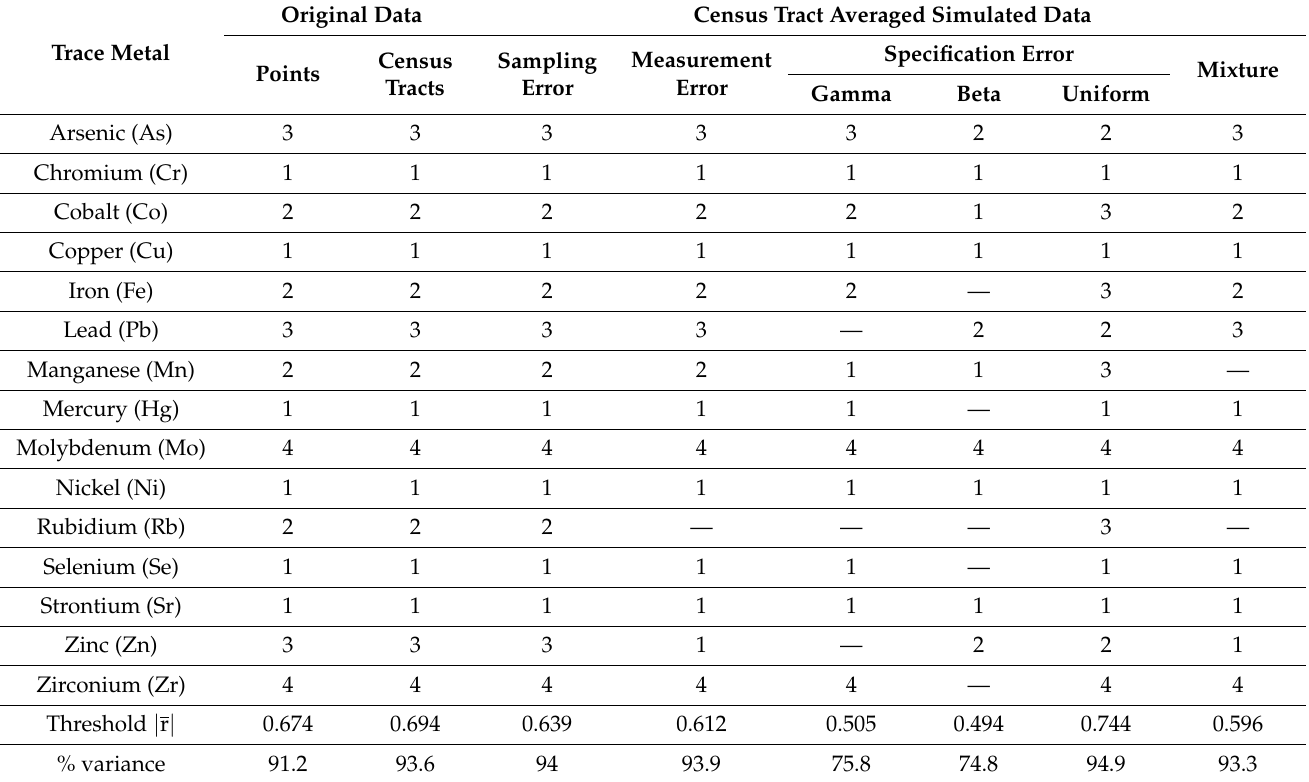
Table 13. Syracuse trace metal analytical error varimax-rotated factor dimension comparisons (Tables 4–9 and